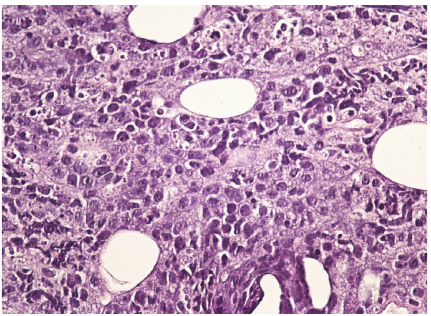
Figure 3: Diffuse large cell lymphoma with atypical lymphocytes, apoptosis, and mitotic figures.